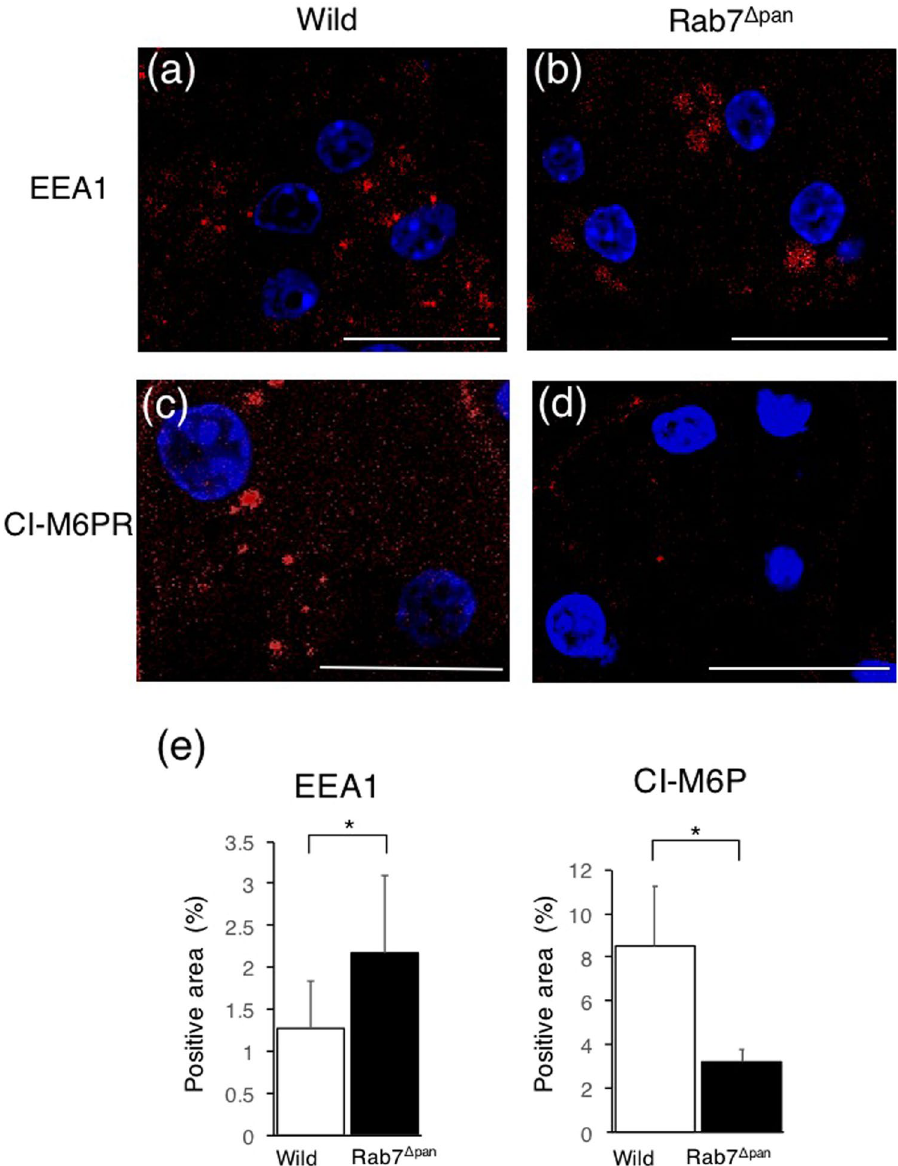
Figure 5. Alteration of the size of early and late endosomes in Rab7 Δ pan pancreatic acinar cells. Immunofluorescence images of wild ( a , c ) and Rab7 Δ pan ( b , d ) pancreases stained with anti-EEA1 ( a , b ) or anti- CI-M6PR ( c , d ) antibodies (red). DAPI was used for nuclear staining (blue). Bars: 20 µ m. ( e ) Quantification of the positive signals in immunofluorescence images of EEA1 (left panel) and CI-M6P (right panel). * P <